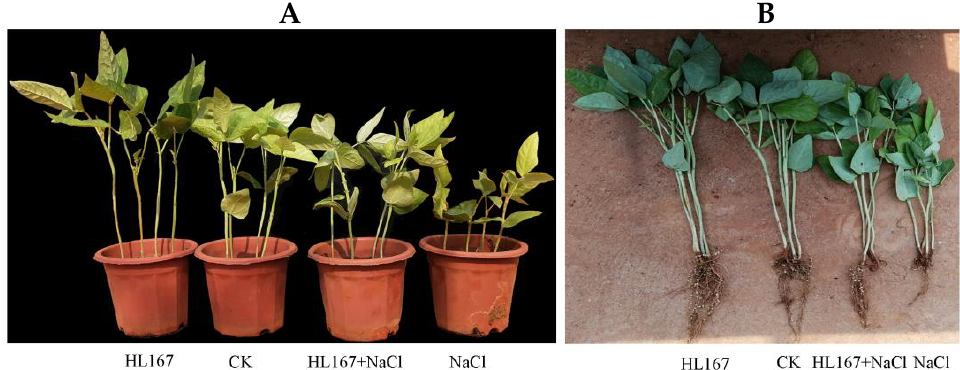
Figure 8. Effect of salt stress and T. longibrachiatum HL167 treatments on cowpea seedling growth. ( A , B ) Growth of cowpea seedlings under different treatments; CK represents cowpea seedlings grown under normal condition; HL167 represents cowpea seeds pretreated with T. longibrachiatum HL167 without salt treatment; HL167 + NaCl represents cowpea seeds pretreated with T. longibrachiatum HL167 and then treated with 200 mM NaCl; NaCl represents cowpea seedlings stressed under 200 mM NaCl. Table 3. Effect of salt stress and T. longibrachiatum HL167 treatments on cowpea plant growth and chlorophyll content.